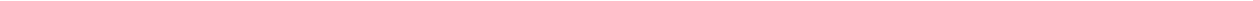
Fig. 2 TRPA1 mediates CCL2-evoked allodynia and neuroin fl ammation. a CCL2 levels in sciatic nerves (at day 10 after surgery) of sham/pSNL Trpa1 +/+ / Trpa1 − / − and C57BL/6 mice after HC-030031 (HC03, 100 mg kg − 1 , i.p.), α -lipoic acid ( α LA, 100 mg kg − 1 , i.p.) or respective vehicles (veh, 4% DMSO and 4% tween 80 in isotonic saline) ( n = 6, *** P < 0.001 pSNL- Trpa1 +/+ vs. sham- Trpa1 +/+ and pSNL-veh vs. sham-veh; one-way ANOVA followed by Bonferroni post hoc analyses). b Mechanical allodynia induced by perineural CCL2 (0.1 – 1 µ g) or vehicle (veh, isotonic saline) in C57BL/6 mice ( n = 4, *** P < 0.001 veh vs. CCL2 (1 µ g), two-way ANOVA followed by Bonferroni post hoc analyses) and CCL2 (1 µ g) in Trpa1 +/+ / Trpa1 − / − and after HC03, α LA (both, 100 mg/kg, i.p.) or respective vehicles (veh, 4% DMSO and 4% tween 80 in isotonic saline) in C57BL/6 mice ( n = 4, *** P < 0.001 Trpa1 +/+ CCL2 vs. Trpa1 +/+ veh; CCL2 veh HC03, α LA vs. veh CCL2; §§§ P < 0.001 Trpa1 − / − CCL2 vs. Trpa1 +/+ CCL2 and CCL2 HC03, α LA vs. CCL2 veh HC03, α LA; two-way ANOVA followed by Bonferroni post hoc analyses). c Representative images, F4/80 + cell number and H 2 O 2 content in sciatic nerves of mice treated with perineural CCL2 (1 µ g) after HC03, α LA (both, 100 mg kg − 1 , i.p.) or respective vehicles (veh, 4% DMSO and 4% tween 80 in isotonic saline) ( n = 5, *** P < 0.001 CCL2 vs. veh HC03, α LA; §§§ P < 0.001 CCL2 HC03, α LA vs. CCL2 veh HC03, α LA; one-way ANOVA followed by Bonferroni post hoc analyses) (Scale bars: 50 μ m, dashed lines indicate perineurium). d CCL2 levels, mechanical allodynia, F4/80 + cell number and H 2 O 2 content in sciatic nerves (at day 10 after surgery) of sham/pSNL C57BL/6 mice after an anti-CCL2 antibody (CCL2-Ab) or IgG2B control (120 µ g 200 µ l − 1 , i.p., single administration) ( n = 6, *** P < 0.001 pSNL-CCL2-Ab vs. sham-CCL2-Ab; §§§ P < 0.001 pSNL-CCL2-Ab vs. pSNL-IgG2B; one-way ANOVA followed by Bonferroni post hoc analyses). Data are represented as mean ±